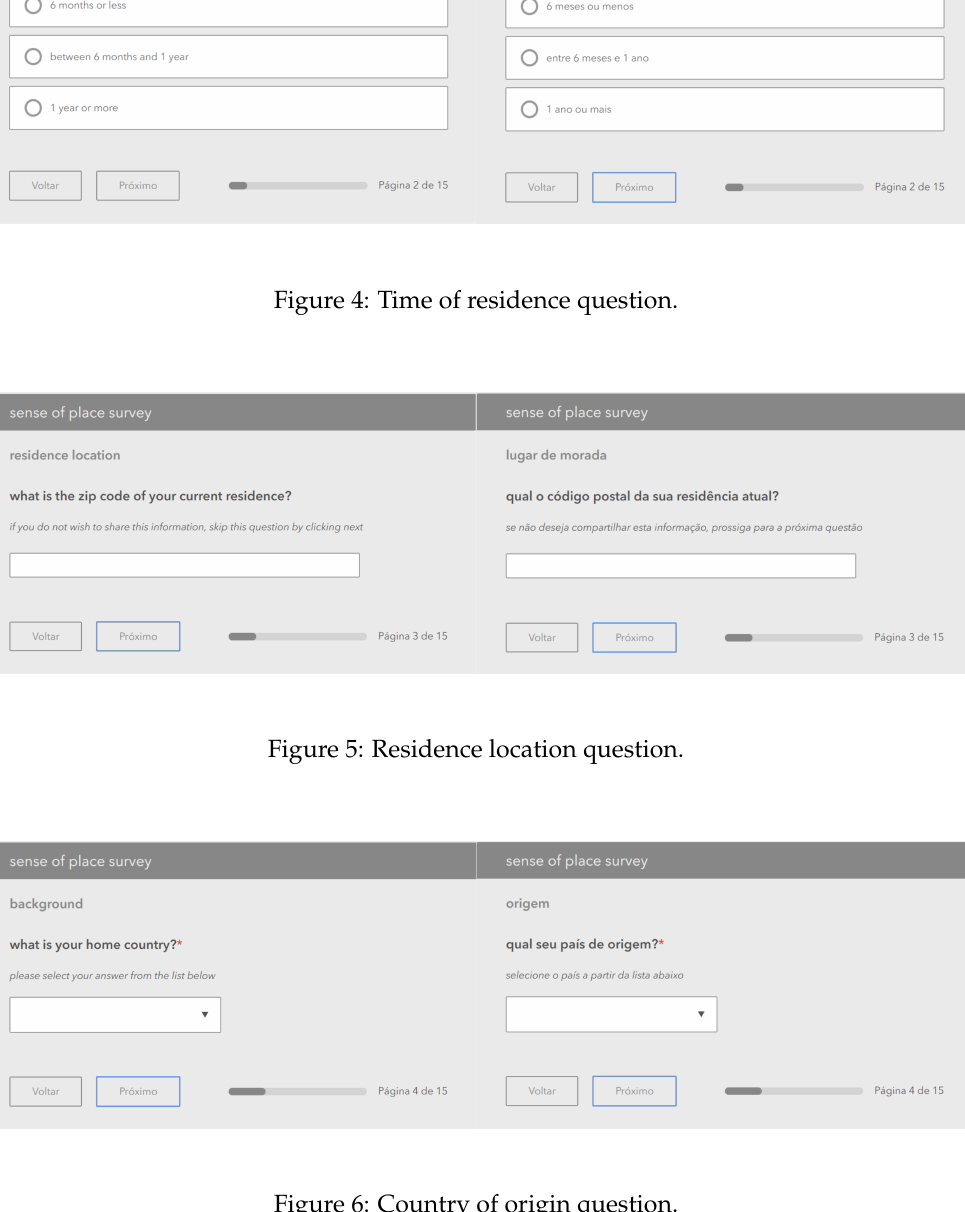
Figure 6: Country of origin